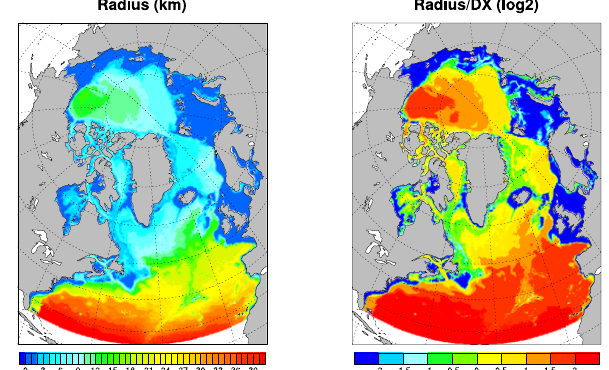
Figure 2. First Rossby radius of deformation (left, in kilometres) and Rossby radius relative to the local resolution in log 2 (right). Grossly speaking, the right panel shows where model is eddy re- solving (values above 1, that is, 2 model points to resolve a baro- clinic eddy), eddy permitting (between 0 and 1) or does not resolve eddies (values below